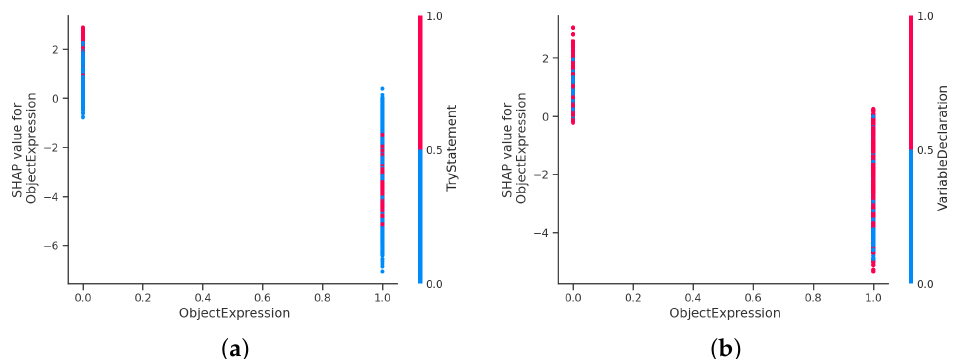
Figure 3. SHAP dependence plot for the top AST-JS feature. ( a ) Before feature selection; ( b ) after feature selection.